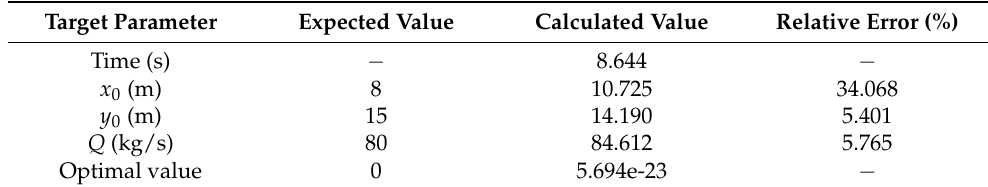
Table 10. Qualitative results table of OMO algorithm under 4